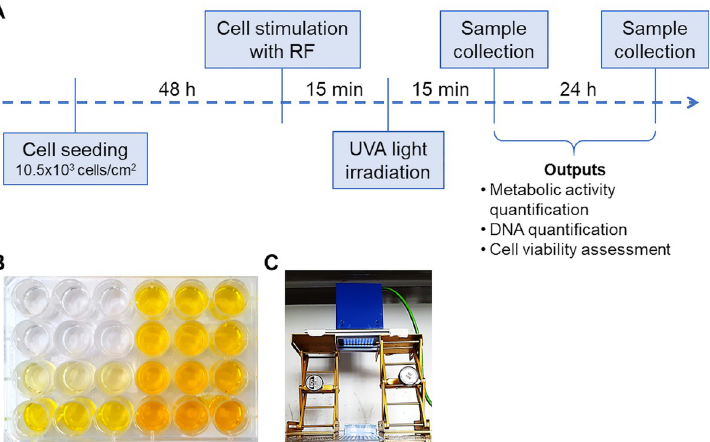
Fig 1. Annulus fibrosus (AF) cell treatment with different concentrations of Riboflavin (RF, 0.05, 0.5, 2 and 8 mM) and UVA light intensities (0.3, 3 and 4 mW/cm 2 ). A) Experimental timeline. B) AF cells treated with RF. C) Experimental setup for AF cells exposure to UVA